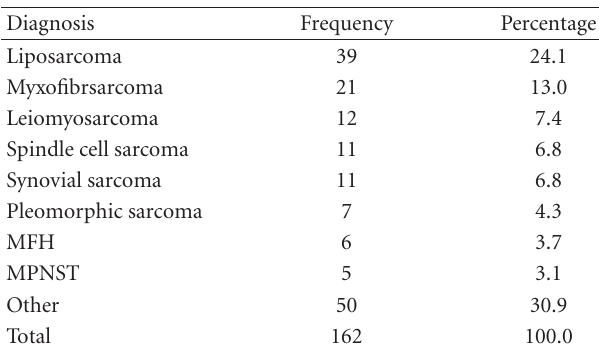
Table 1: Histological